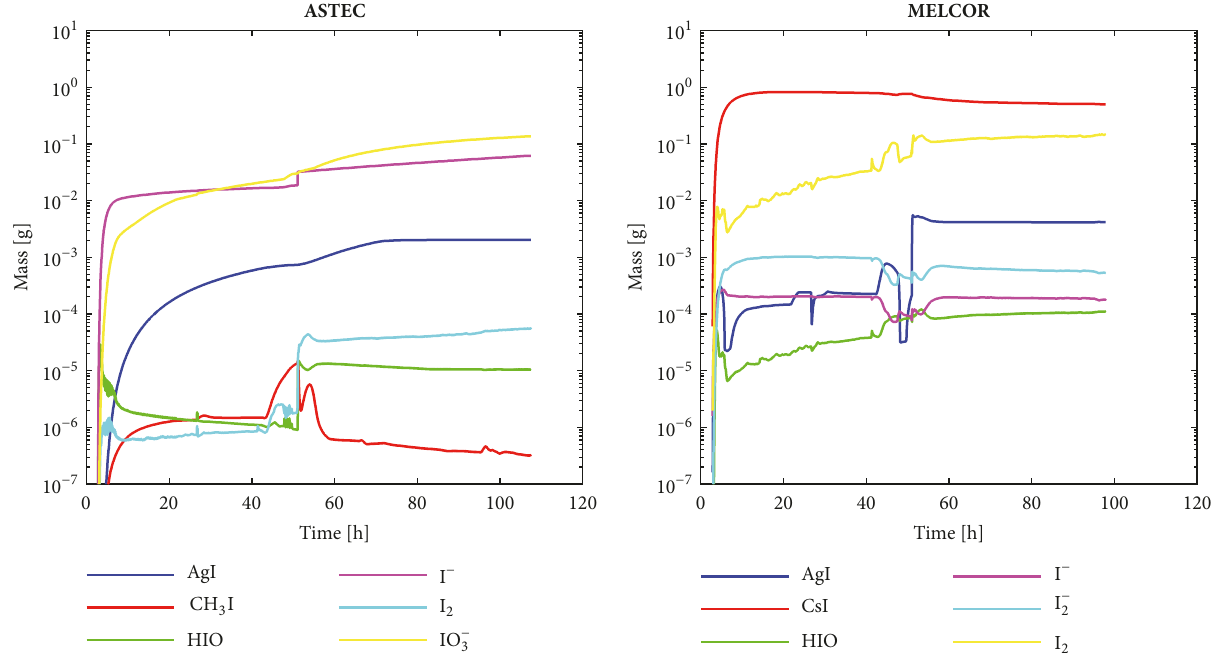
Figure 16: Iodine speciation in the sump water during the Ph´ebus FPT-3